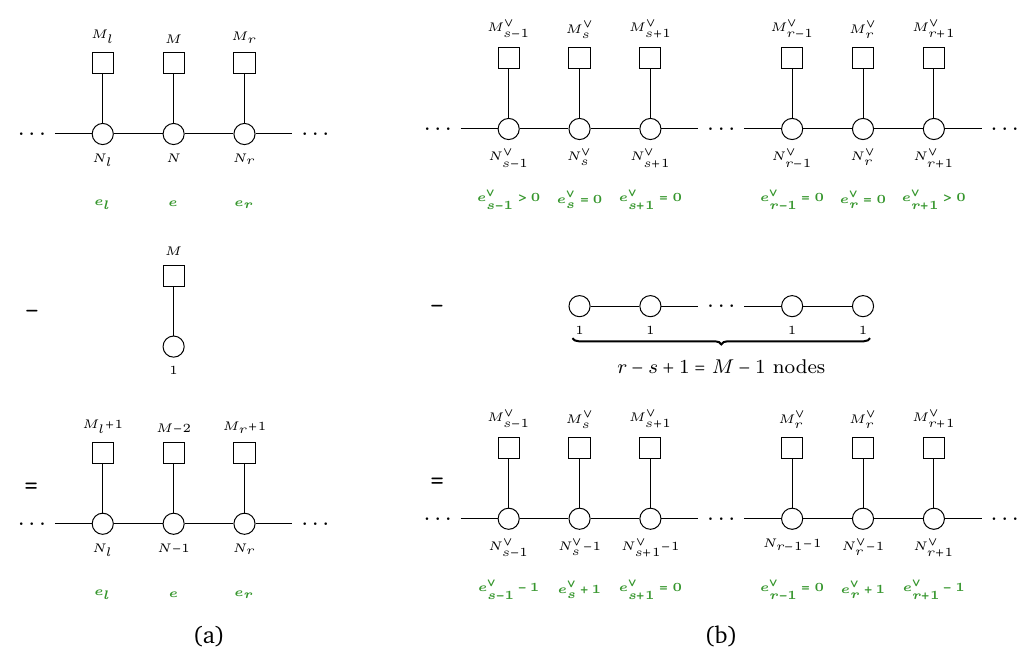
Figure 9: a: The a transition on the Higgs branch is realised by subtracting the M − 1 quiver of U ( 1 ) SQED with M flavours and adjusting the flavour nodes such that the balance e is preserved. b: In the mirror, the exists a sequence of M − 1 balance nodes i and the Coulomb branch transition is realised by subtracting a finite A